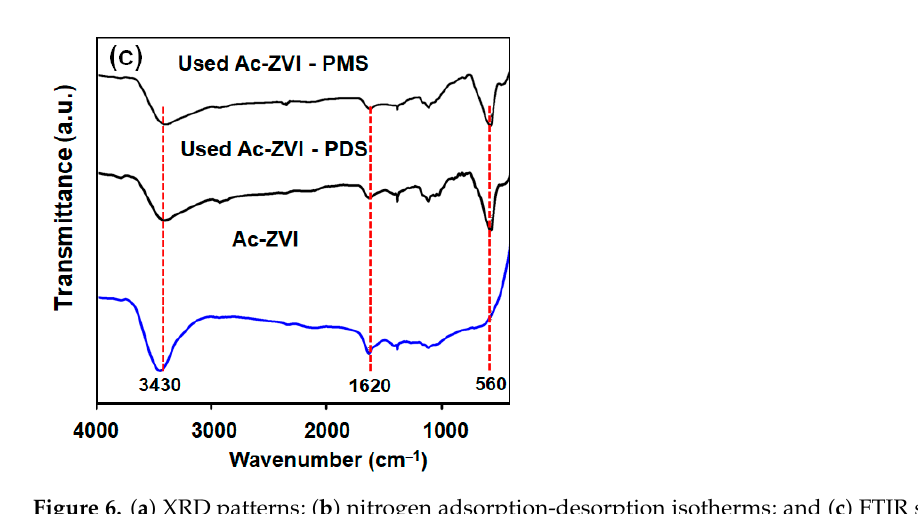
Figure 6. ( a ) XRD patterns; ( b ) nitrogen adsorption-desorption isotherms; and ( c ) FTIR spectra of pristine and used Ac-ZVI.